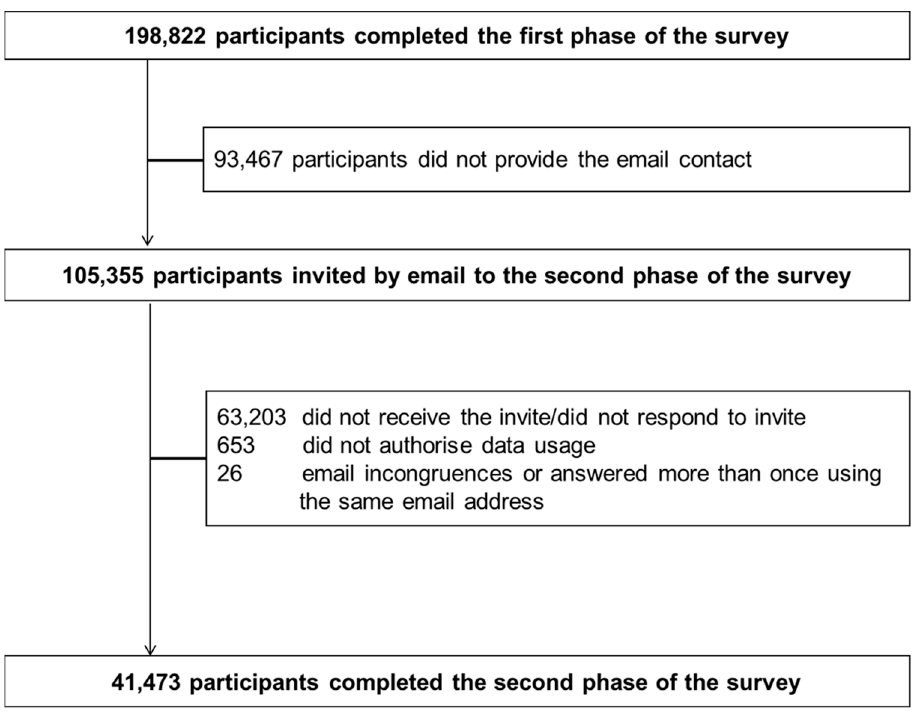
Figure 1. Flow-chart of the participants in phase II EPICOVID19 survey.